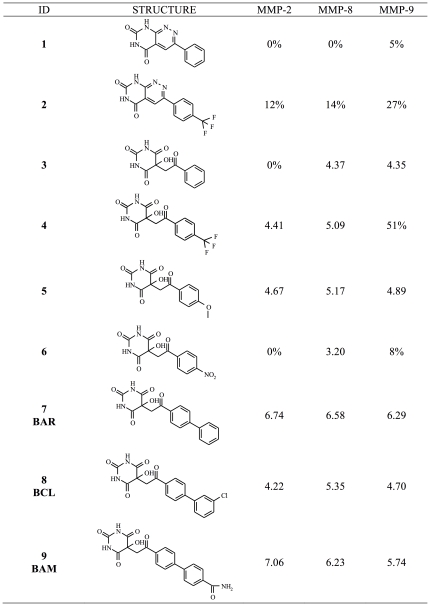
Biological data of alloxan-based compounds 1–9.We report the pIC50 or % of inhibition at 100 µM.